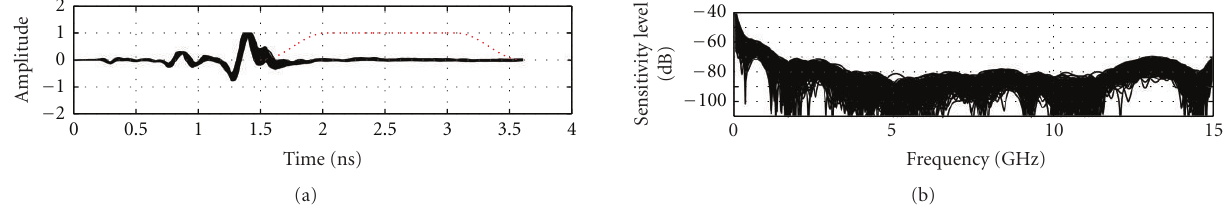
Figure 9: Time domain representation and noise level of the later-time antenna response (under dashed window).